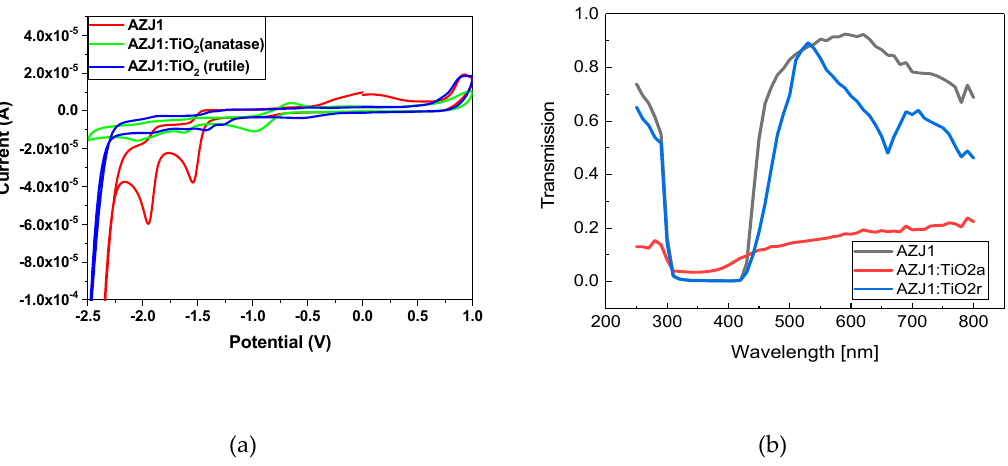
Figure 8. ( a ) Cyclic voltammograms (CV) of the mixture of AZJ1 with two different TiO 2 crystallographic structures—rutile and anatase—in solution. CV sweep rate ν = 100 mV s − 1 , 0.2 M Bu4NPF6 in acetonitrile. ( b ) UV-Vis transmission spectra (transmission spectra of TiO 2 suspensions in chloroform are presented in Figure S7).